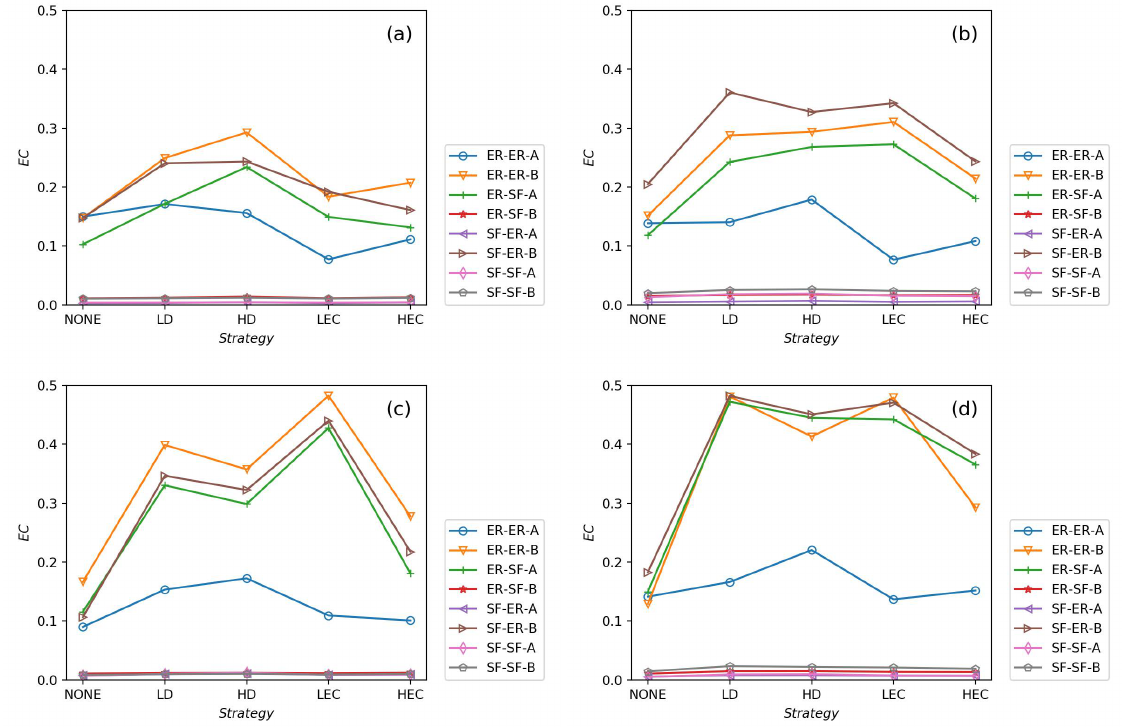
Figure 8. The values of eigenvector centrality values in systems when f L = 15%, f L = 25%, f L = 35% and f L = 45% are shown in ( a – d ),